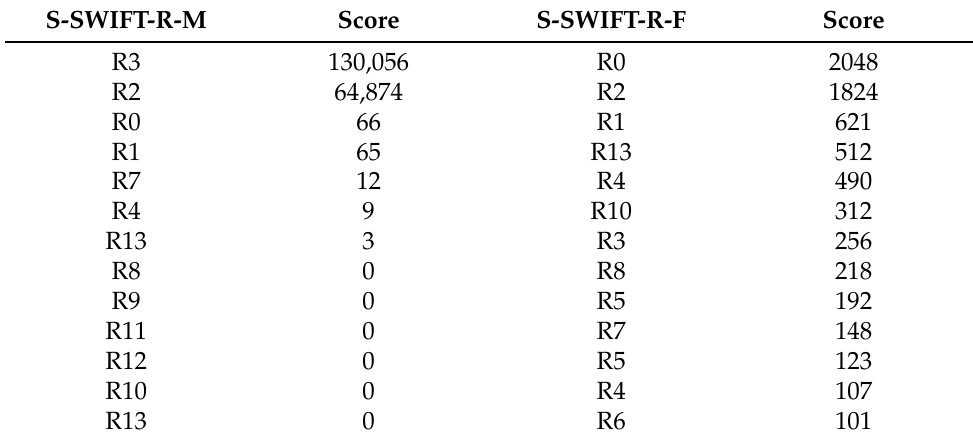
Table 1. Register usage report of DIJ case